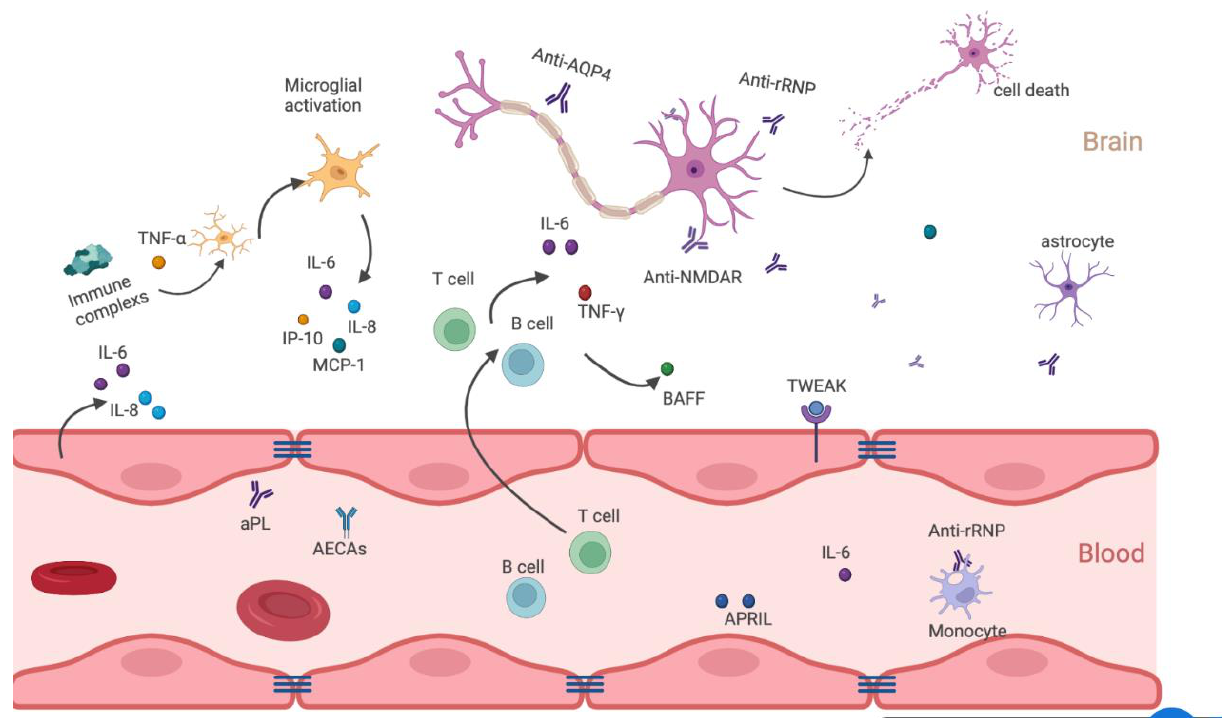
Figure 1. Pathogenetic mechanisms in diffuse NPSLE.